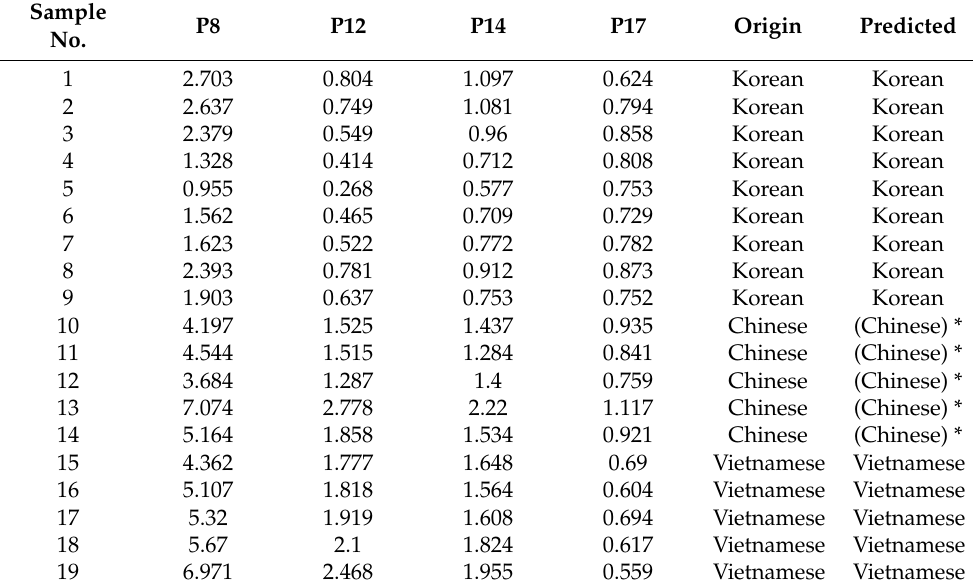
Table 8. Classification of the blind samples based on their geographical origins using the ranges of the indicator variables for Korean and Vietnamese